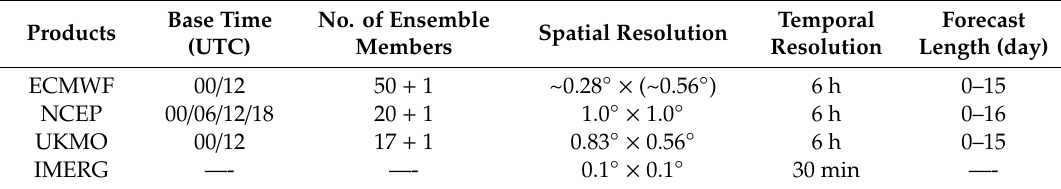
Figure 1. The spatial distribution of in situ observations on the elevation map of Iran. Table 1. Characteristics of the studied NWP models and IMERG satellite.